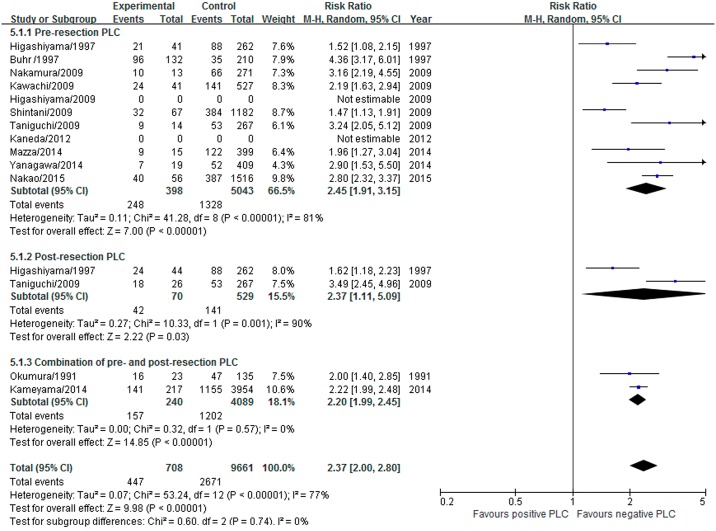
Effect of positive PLC on the overall recurrence.